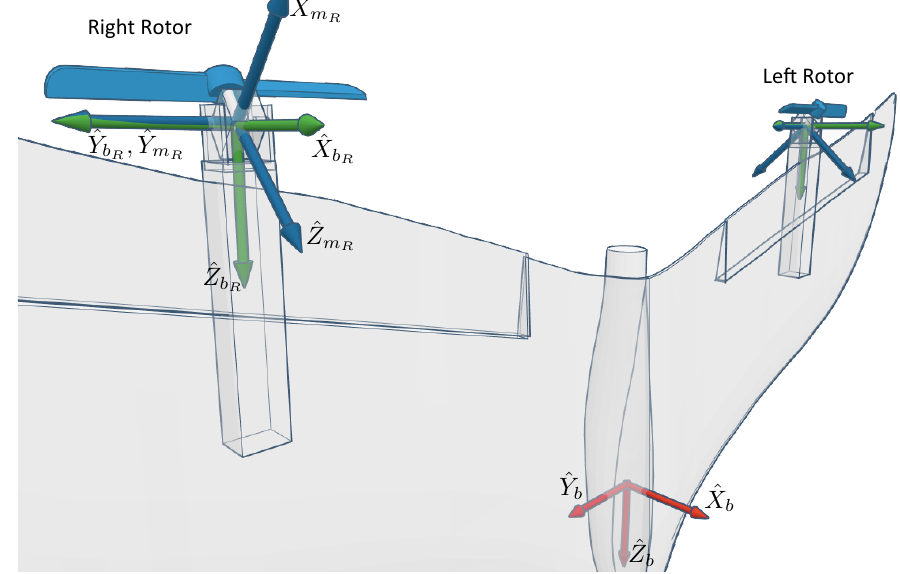
Figure 4. Right rotor coordinate reference